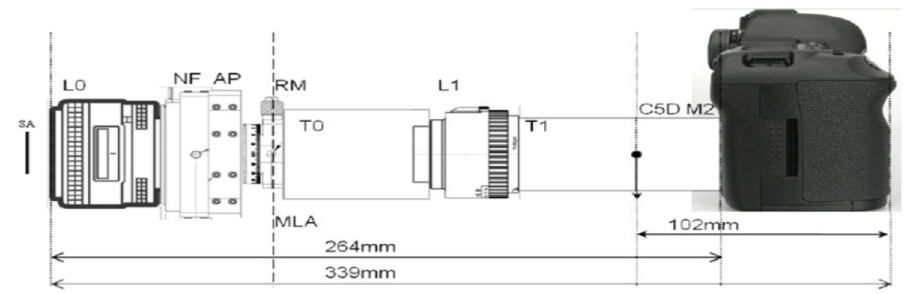
Figure 3 . Square Aperture Type 2 camera integration with canon 5.6 k sensor [21].